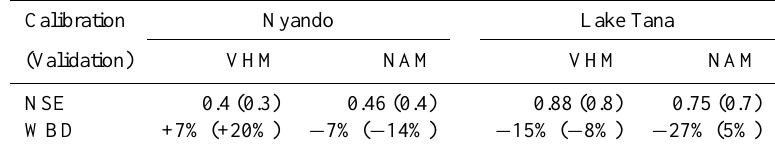
Fig. 3. Model structure of NAM and description of the basic parameters (DHI, 2008). Table 1. VHM and NAM model performance in simulating the historical records for calibration and validation period.